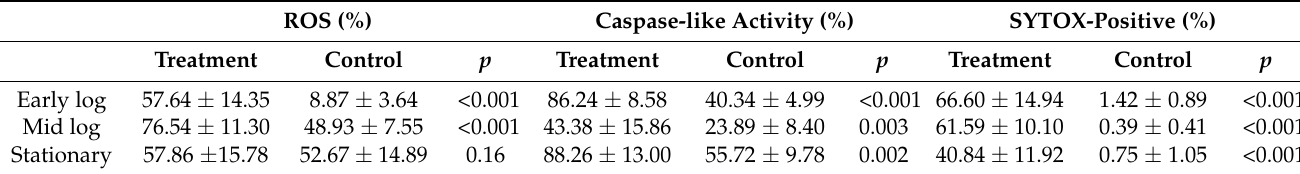
Figure 1. Cellular stress responses in K. brevis cells exposed to 180 μM H 2 O 2 (circles) and their corresponding control cultures (triangles) at early-log phase ( A , D , G , J ), mid-log phase ( B , E , H , K ) and stationary phase ( C , F , I , L ). ( A – C ) Proportion of cells showing reactive oxygen species (ROS). ( D – F ) Proportion of cells showing caspase-like activity. ( G – I ) Proportion of cells stained with SYTOX. ( J – L ) Live cell density. Data points show average values obtained from triplicate cultures, and error bars show standard deviation of the replicates ( n = 6). Asterisks indicate a significant difference between treatments and controls ( p < 0.05). Table 1. Average percentages of cellular parameters in treatments and controls from all sampling time points during the 48 h experiment at early-log, mid-log and stationary phase. Error bars show standard deviation of the replicates ( n = 30). p -value between treatments and controls in each growth phase from RM-ANOVA analysis are also listed.